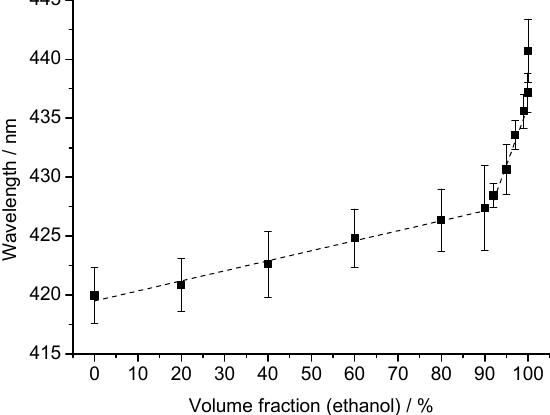
Figure 4. Effect of the fraction of ethanol in water on the peak wavelength of light reflected by PCCA films consisting of polystyrene nanoparticles in polydimethylsiloxane. The error bars show the standard deviation of the evaluation from five individual experiments with the same PCCA